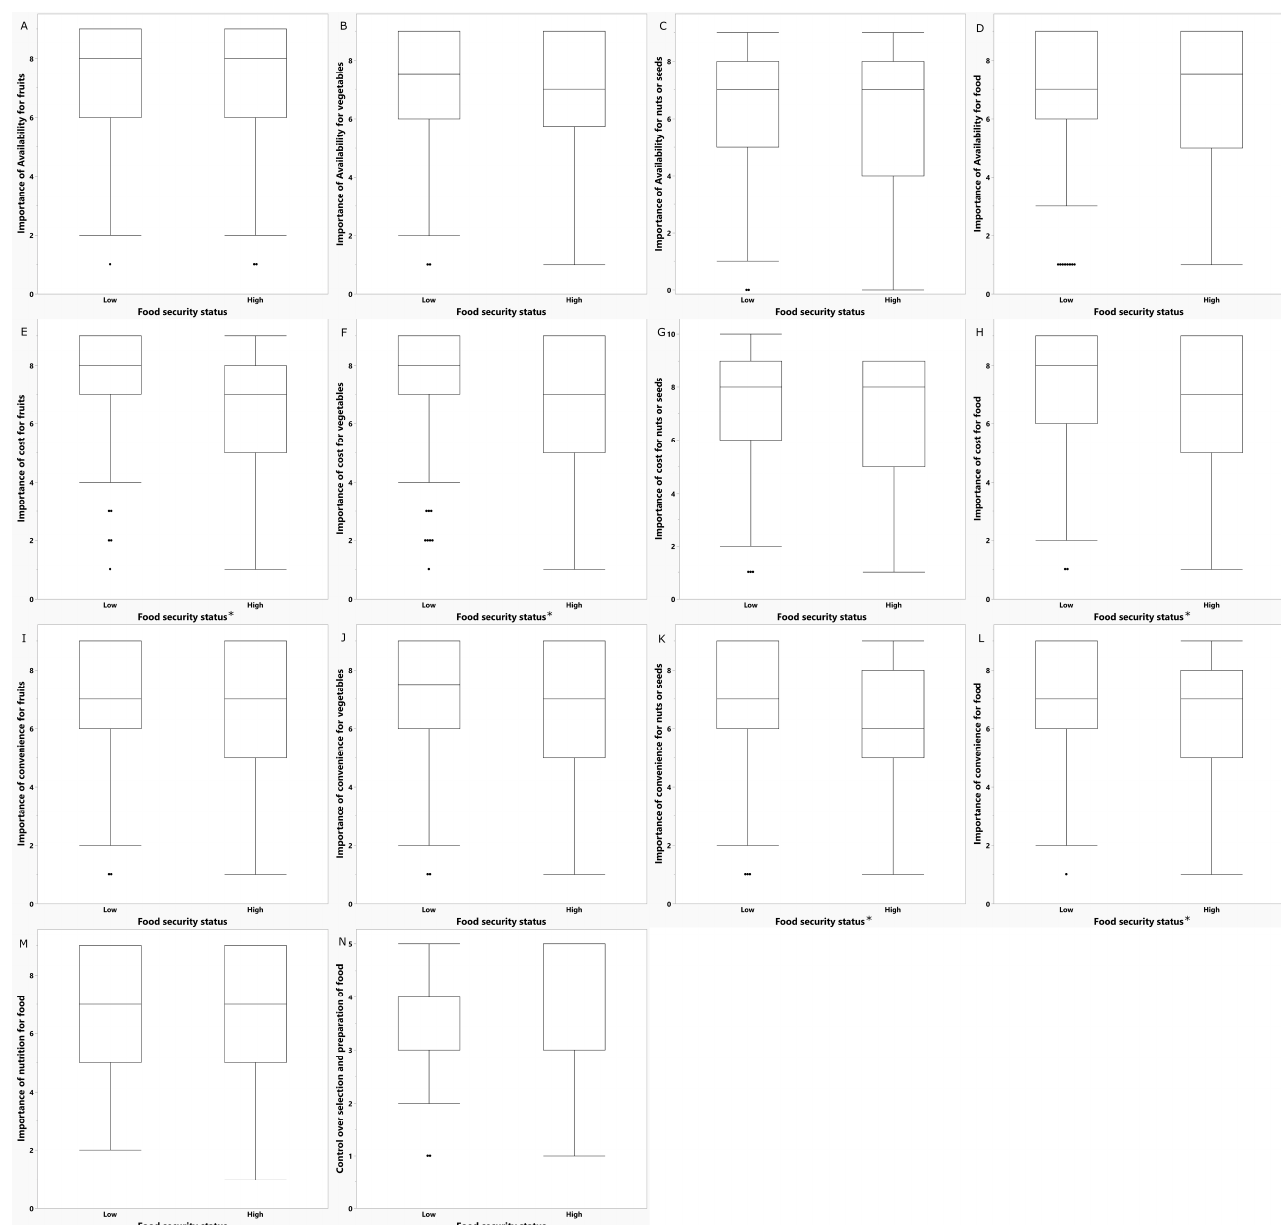
Figure 2. Ratings of importance of factors for food consumption by food security status. * Q < 0.1 for comparisons within categories: ( A ) Importance of availability for fruit; ( B ) Importance of availability for vegetables; ( C ) Importance of availability for nuts or seeds; ( D ) Importance of availability for food; ( E ) Importance of cost for fruits; ( F ) Importance of cost for vegetables; ( G ) Importance of cost for nuts or seeds; ( H ) Importance of cost for food; ( I ) Importance of convenience for fruits; ( J ) Importance of convenience for vegetables; ( K ) Importance of convenience for nuts or seeds; ( L ) Importance of convenience for food; ( M ) Importance of nutrition for food; ( N ) Control over selection and preparation of